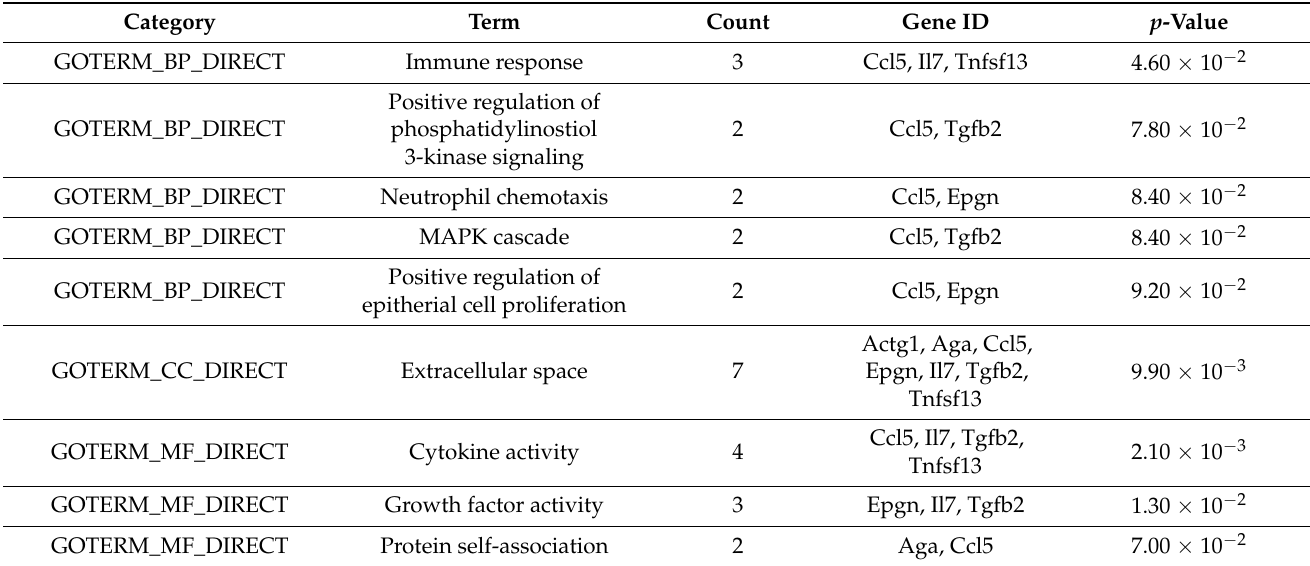
Table 1. A list of the gene ontology term enrichment analysis among over 4-fold upregulated genes in JE-1 stimulated with 0.2 mM